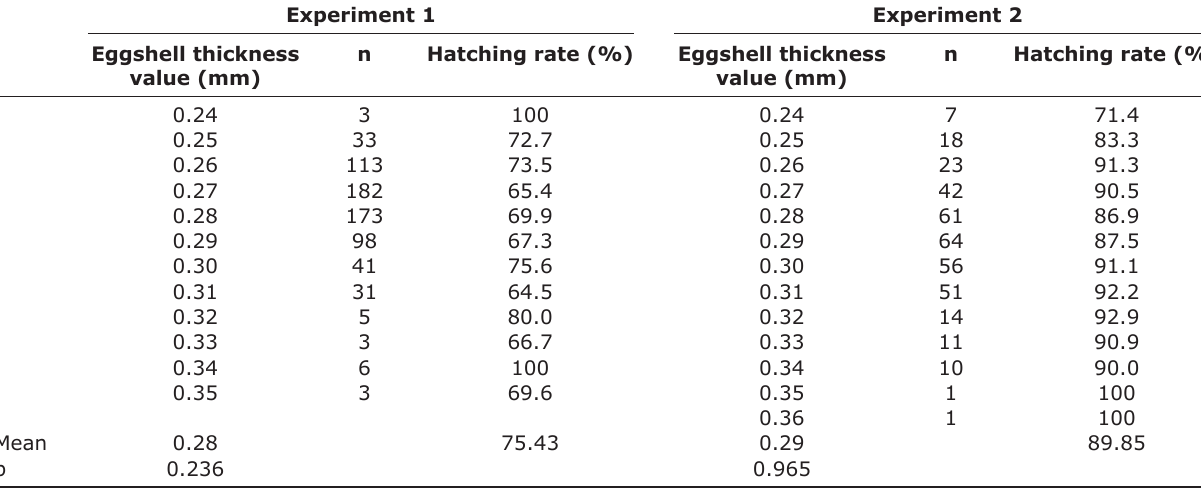
Table-1: Hatching rates of eggshell thickness values in two different experiments.